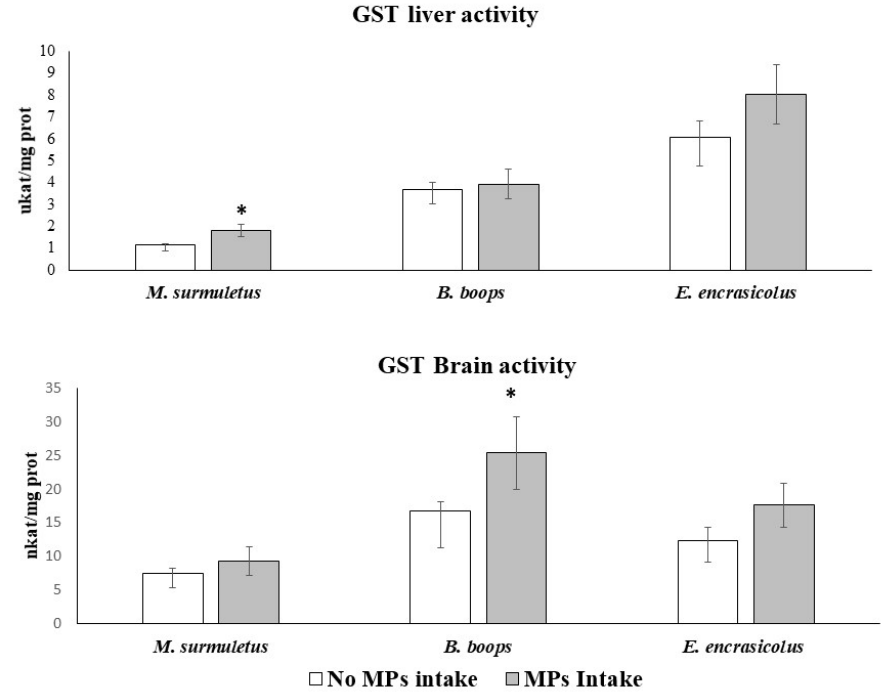
Figure 3. GST activity in both tissues in the three study species. * indicates significant differences with respect to no MP ingestion. Brain and liver of 44 M. surmuletus , 51 B. boops , and 34 E. encrasicolus were used to perform this determination. Statistical analysis: one-way ANOVA. p < 0.05.